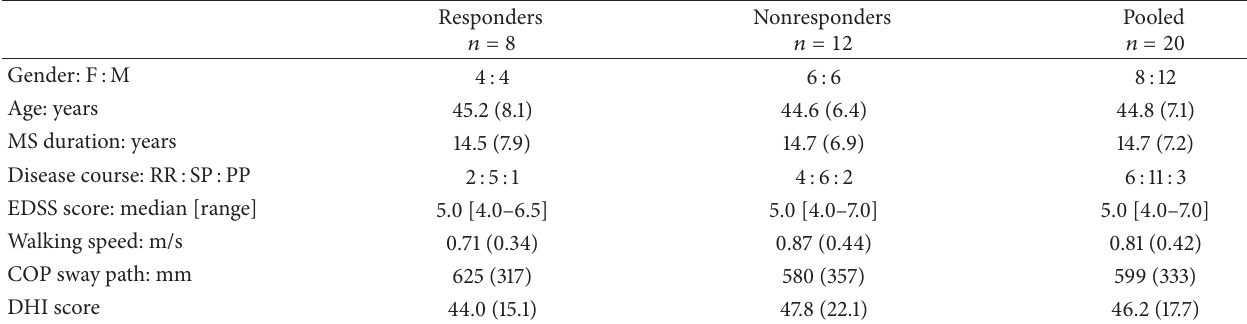
Table 1: Patients’ characteristics at study entry.